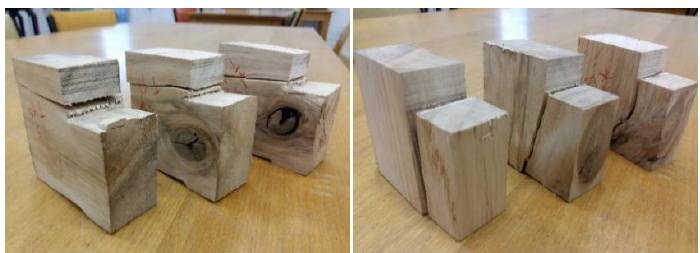
Figure 7. Failure modes of SPE (left) and SPA (right) with and without knot.